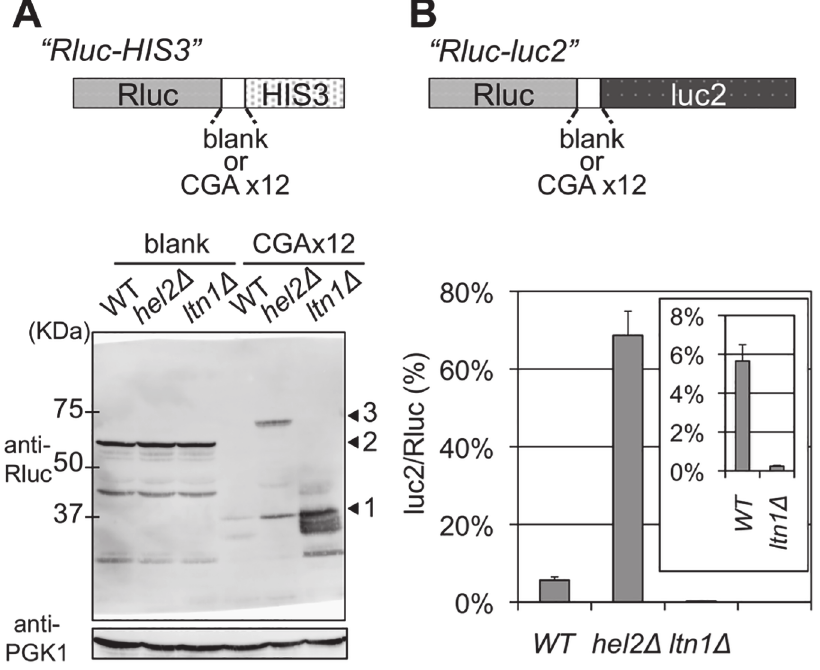
Fig 1. Comparisons of the effects of deleting Hel2 and Ltn1. (A) Western blot analysis for Rluc-HIS3 reporters from the wild-type (WT), hel2 Δ , and ltn1 Δ strains (BY4727, SKY61, S18-E01). A schematic image of reporter fusion genes, Rluc-HIS3, either with or without 12 CGA codon repeats, is illustrated above. The expression of fusion protein was detected using a Rluc antibody. PGK1 was used as a loading control. Arrowhead 1 indicates the Rluc protein alone, arrowhead 2 indicates the Rluc-blank-HIS3 protein, and arrowhead 3 indicates the Rluc-CGA x12-HIS3 protein. (B) Dual luciferase assay for Rluc-CGA x12-luc2 reporter in the wild-type (WT), hel2 Δ , and ltn1 Δ strains (HRKW-2, SKY113, HRKW-6). A schematic image of reporter fusion genes, Rluc-luc2, either with or without 12 CGA codon repeats, is illustrated above. Bars indicate luc2/Rluc ratios. Percentages were standardized using the results of a dual luciferase assay for Rluc- blank-luc2 in the wild-type strain (HRKW-1). The inset indicates the results with the ltn1 Δ strain with an appropriately adjusted range. Average luc2/Rluc ratios and standard deviations were determined from three independent